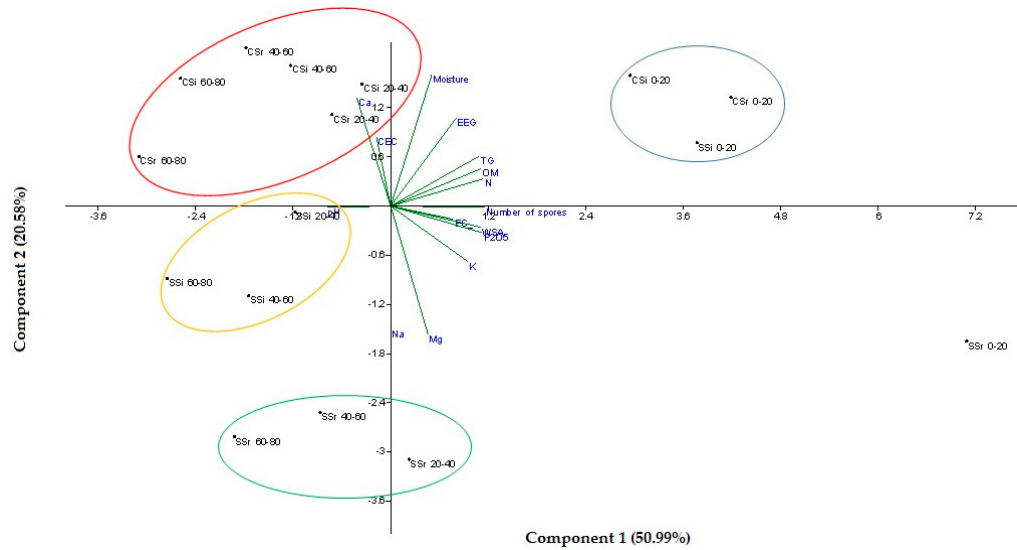
Figure 6. Principal Component Analysis of the measured variables in relation to soil management, distance from the tree, and soil depth.